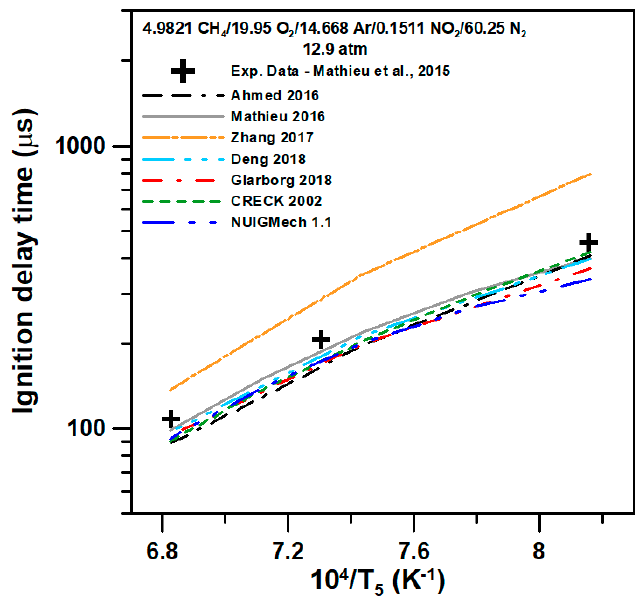
Figure 1. Comparison of ignition delay time measurements from Mathieu et al. [13] with predictions from literature models.